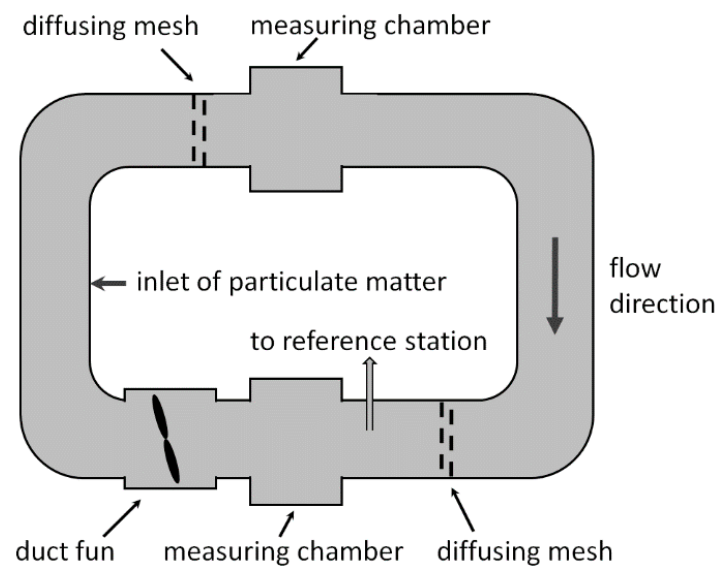
Figure 1. View of the calibration system.